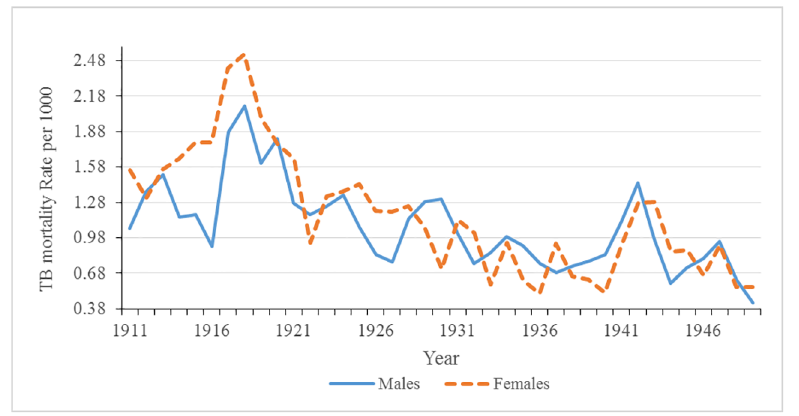
Fig 8. Male and female tuberculosis mortality rates: Malta 1911–1949.